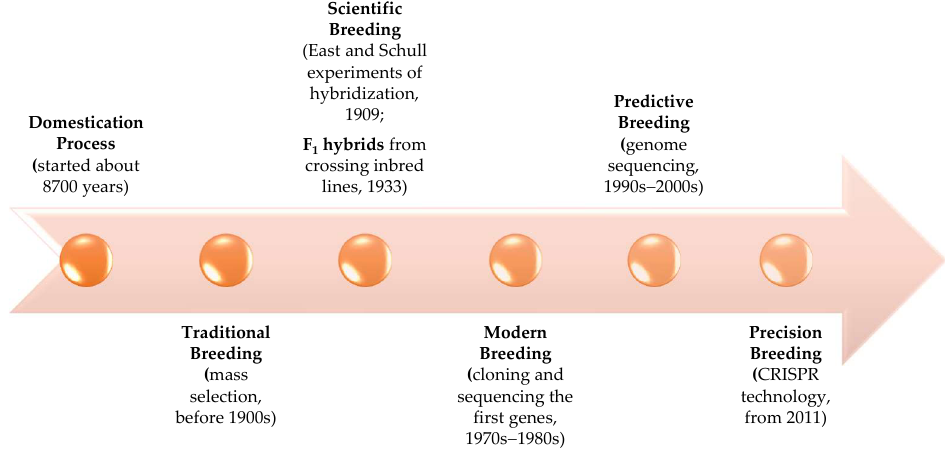
Figure 1. Maize breeding stages: from plant domestication to precise improvement.